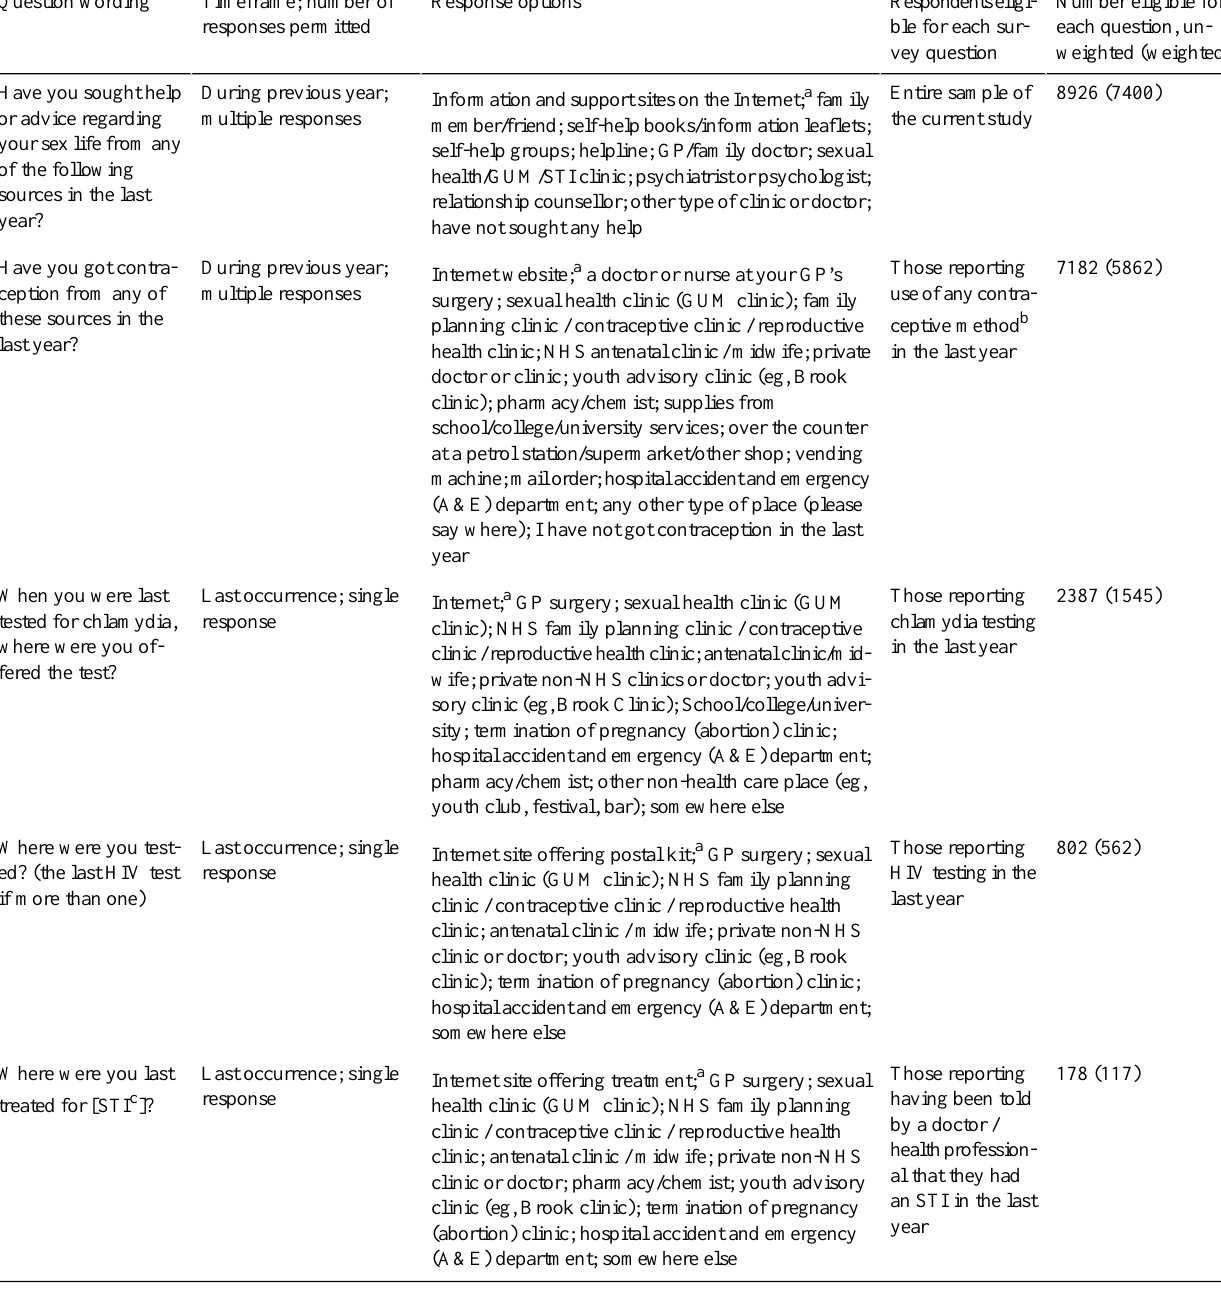
Table 1. Details of the Natsal-3 survey questions used as outcome variables in these analyses of sexually experienced persons aged 16 to 44 years (unweighted N=8926, weighted